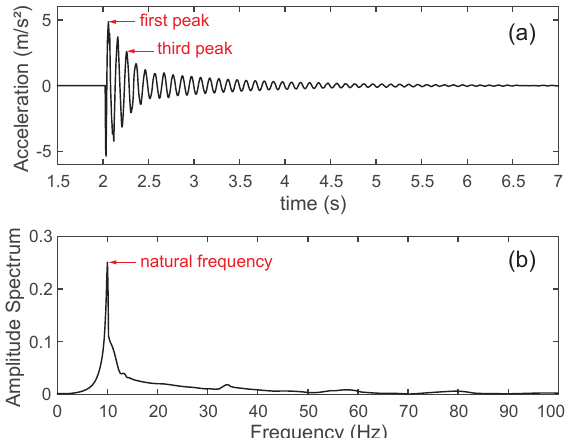
Figure 3. Vibration test on one specimen: ( a ) acceleration at mid-span over time; ( b ) frequency spectrum of the